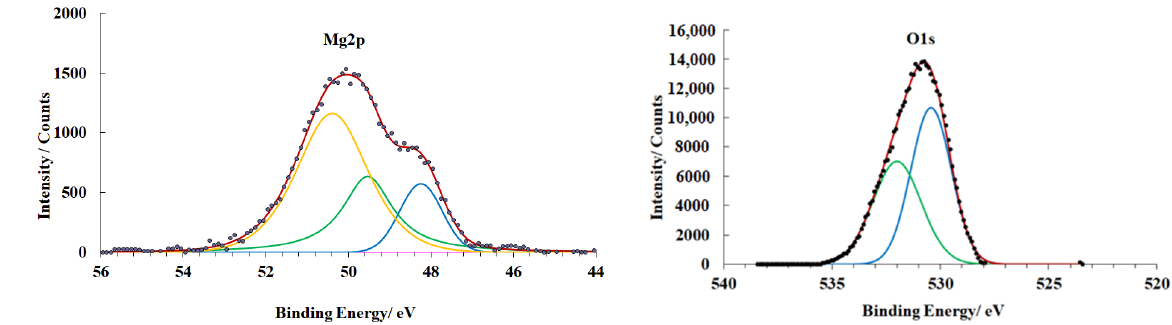
Figure 5. XPS spectra of magnesium alloy samples (preparation mode A ).